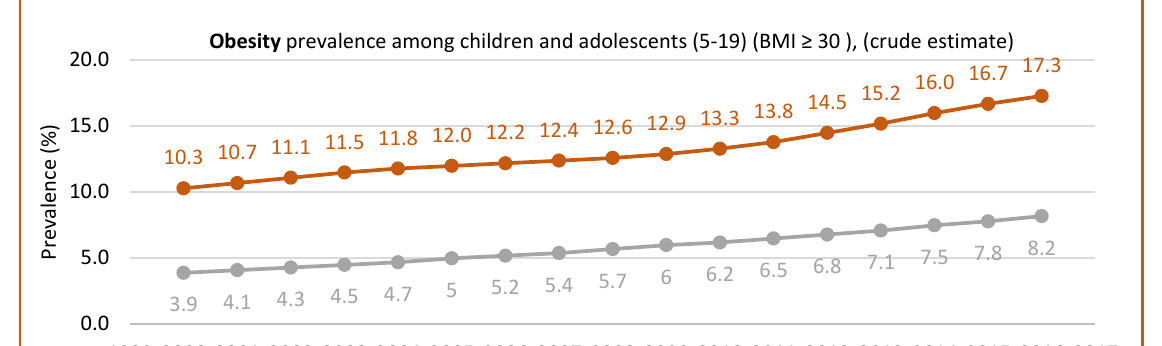
Figure 3. Overweight prevalence in children and adolescents (aged 5 – 19 years) (BMI ≥ 25) (crude estimate). Source: https://www.who.int/data/gho/data, http://www.healthdata.org/results/country- profile (accessed on 5 December 2022) [33,35].